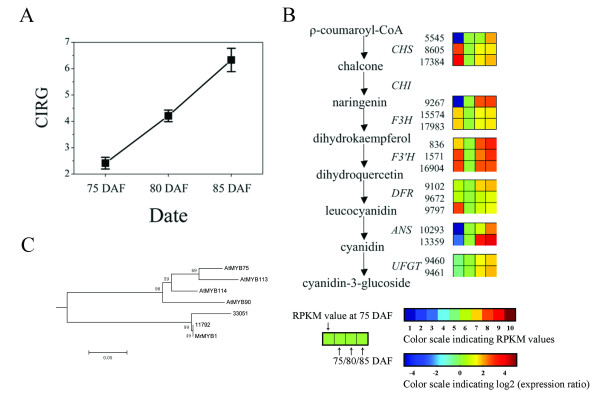
Schematic of physiological and metabolic data related to bayberry fruit color during ripening. (A) Changes in CIRG values during fruit ripening, (B) anthocyanin biosynthesis pathway. Enzyme names, UniGene ids and expression patterns are indicated on the right of each step. The expression patterns of each UniGenes are shown by 4 grids, with the left one representing the RPKM value at 75 DAF, and the second to fourth ones from the left to the right representing the relative log2 (expression ratio) at 75, 80, 85 DAF, respectively. The grids with 10 different colors from blue to red show the absolute expression magnitude at 75 DAF, with the RPKM values 0-10, 10-20, 20-40, 40-80, 80-160, 160-320, 320-640, 640-1280, 1280-2560, and over 2560 represented by colors 1 to 10, respectively, (C) An anthocyanin-related branch of the phylogenetic tree comparing Chinese bayberry R2R3-MYBs amino acid sequences with all MYBs from Arabidopsis thaliana.